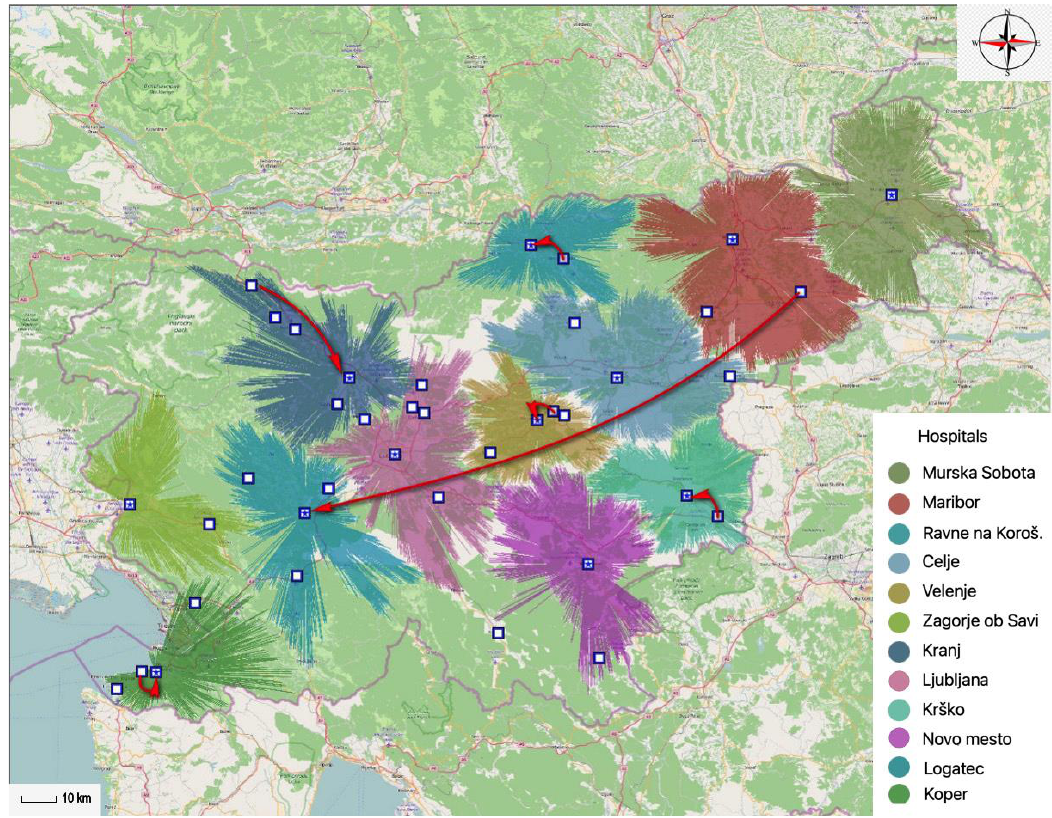
Figure 3. Comparison of existing and optimally located general hospitals within a 45-min time in- terval.